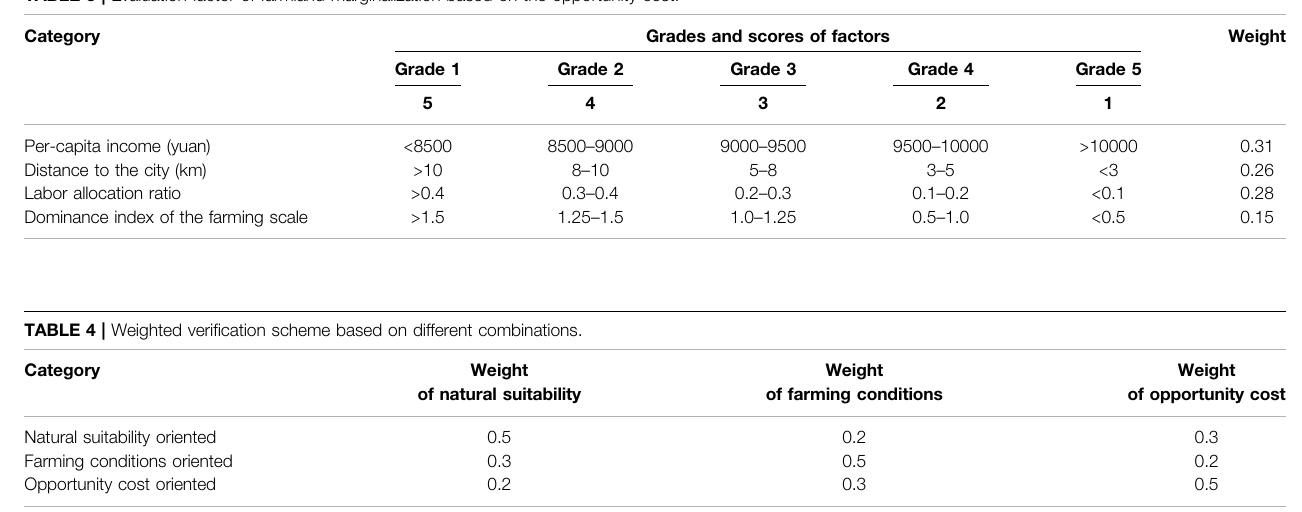
TABLE 3 | Evaluation factor of farmland marginalization based on the opportunity cost.